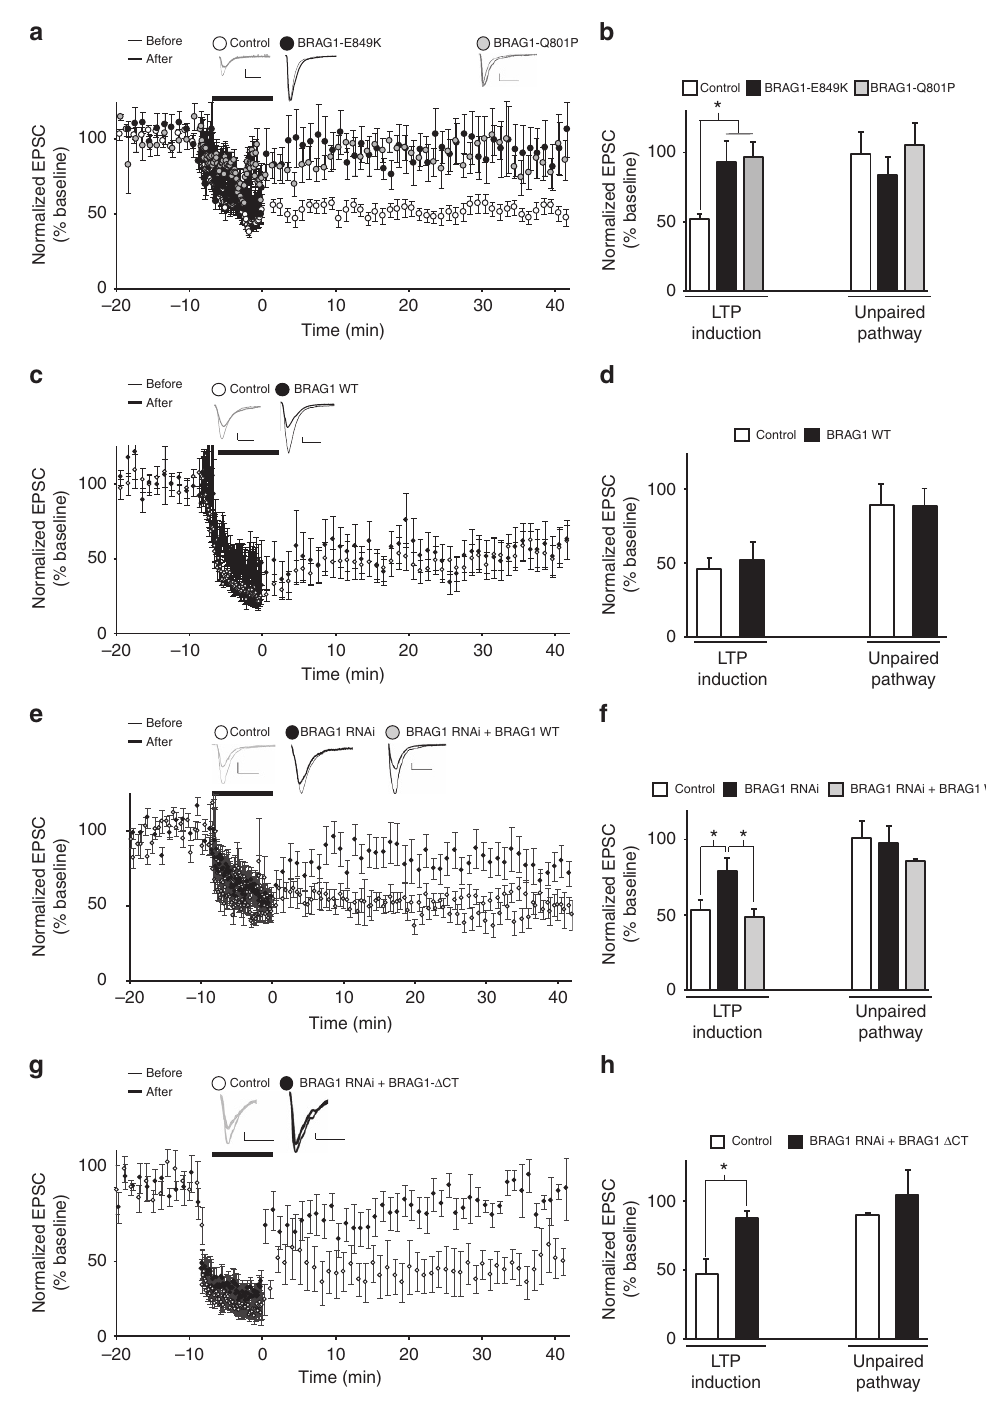
Figure 10 | Arf-GEF activity and PDZ-binding sequence are required for LTD. LTD was induced by pairing a low-frequency stimulation (500 pulses